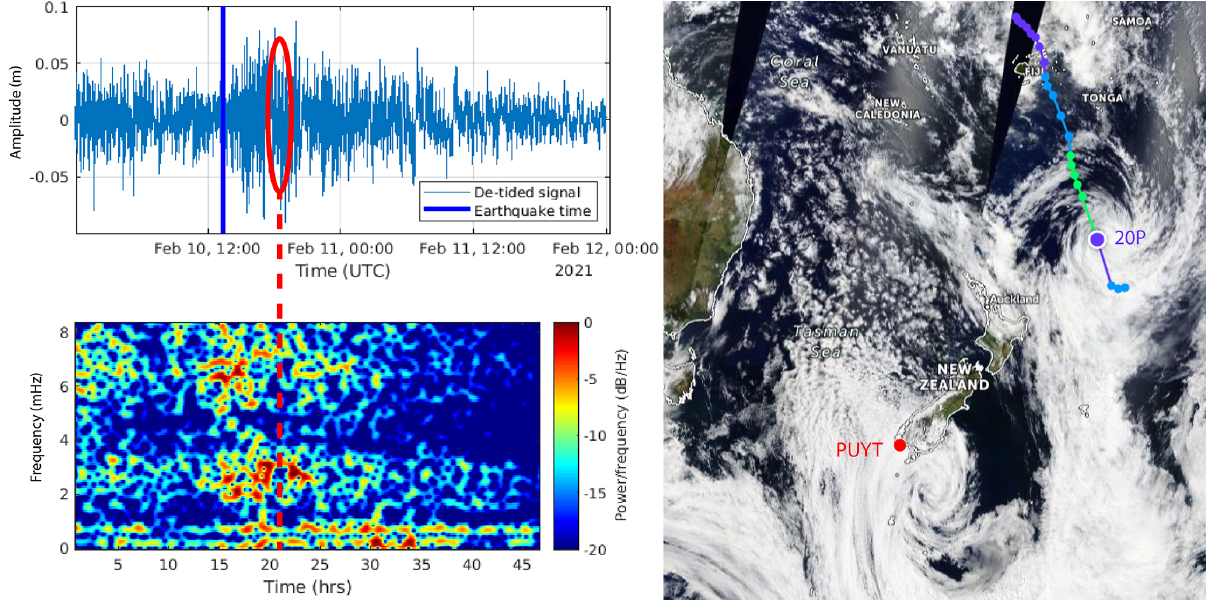
Figure 7. Two storms on 10 February 2021 in the south-west Pacific Ocean. The south one is recorded by the Puysegur gauge (PUYT) at the predicted arrival time of the tsunami (red ellipse and dashed line) (satellite image credits: Zoom Earth, NASA/NOAA/GSFC/EOSDIS, Suomi-NPP VIIRS).